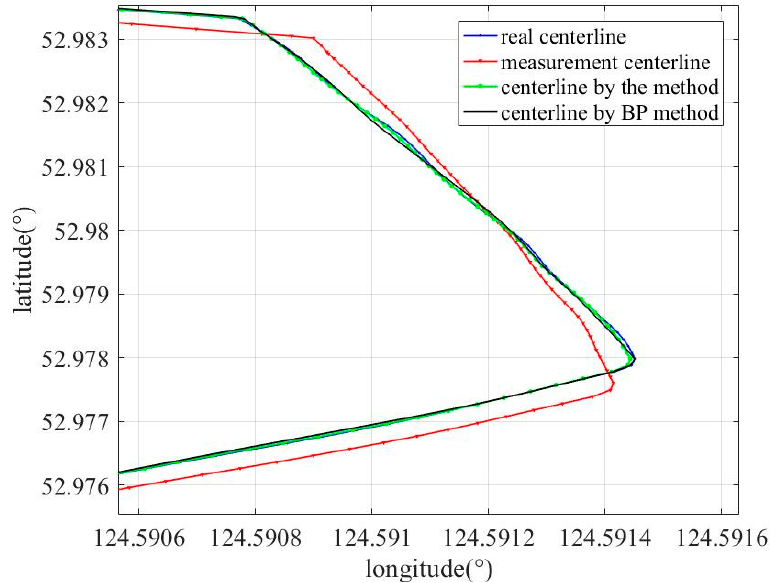
Sensors 2019 , 19 , x FOR PEER REVIEW Figure 14. Centerline modified by different methods. Figure 14. Centerline modified by di ff erent methods.